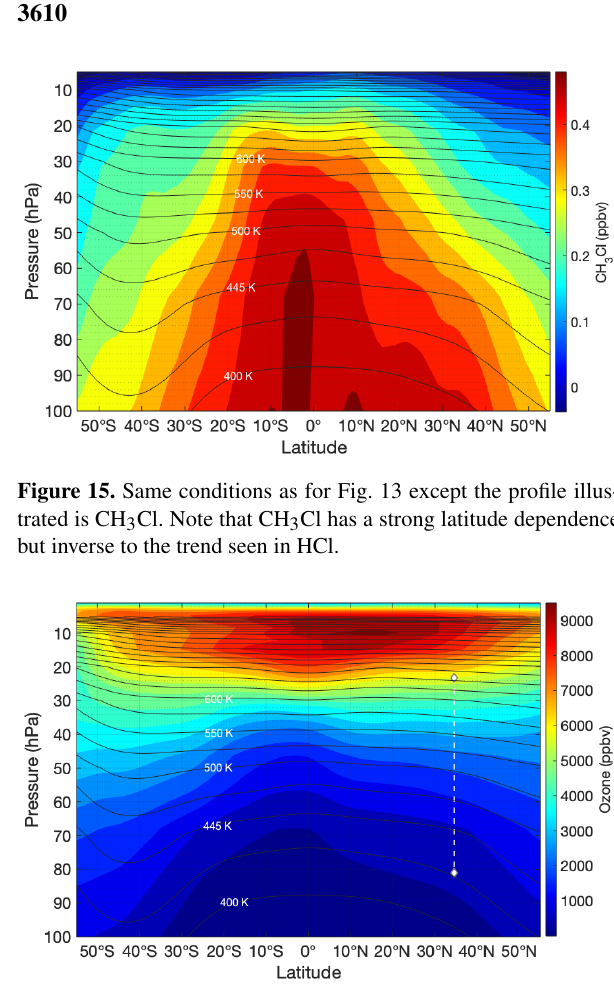
Figure 16. Same conditions as for Fig. 13 except the profile illus- trated is ozone. Note that ozone has very little latitude dependence at the altitudes and latitude at which HUSCE observations were made, especially compared to HCl.